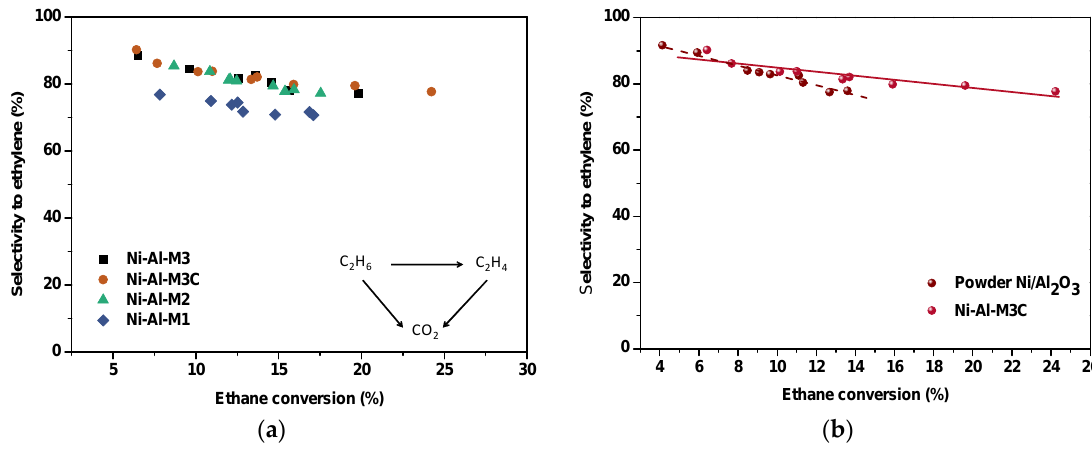
Figure 9. Ethylene selectivity vs. ethane conversion at 450 ◦ C—Variable W/F (0.15–1.3 g · s/cm 3 ), ( a ) structured catalysts and ( b ) comparison between Ni-Al-M3C and the powder catalyst.